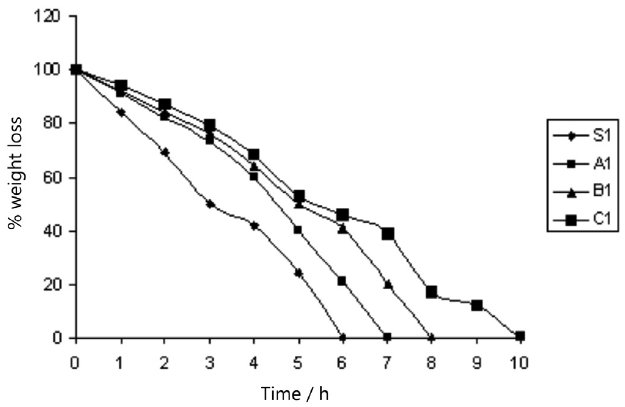
FIGURE 3 - % weight loss of different hydrogel beads due to